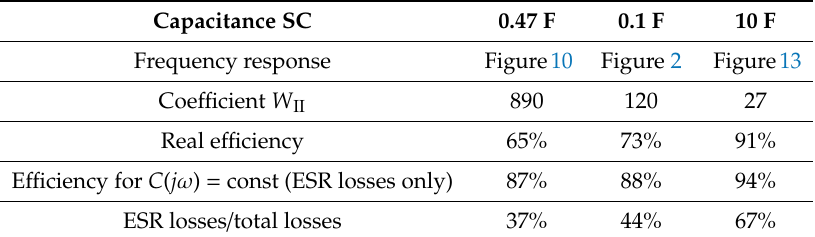
Table 2. Energy e ffi ciency of SC for test conditions.